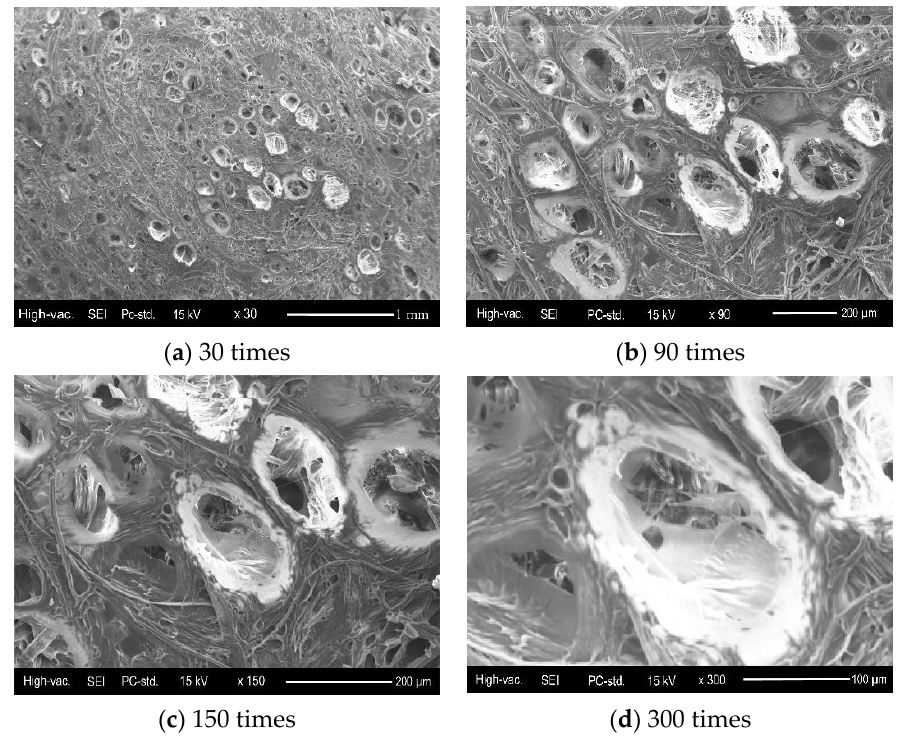
Figure 1. Morphology of the surface of a sample (PVA content of 10.91%) at different magnifications. ( a ) 30 times; ( b ) 90 times; ( c ) 150 times; ( d ) 300 times.